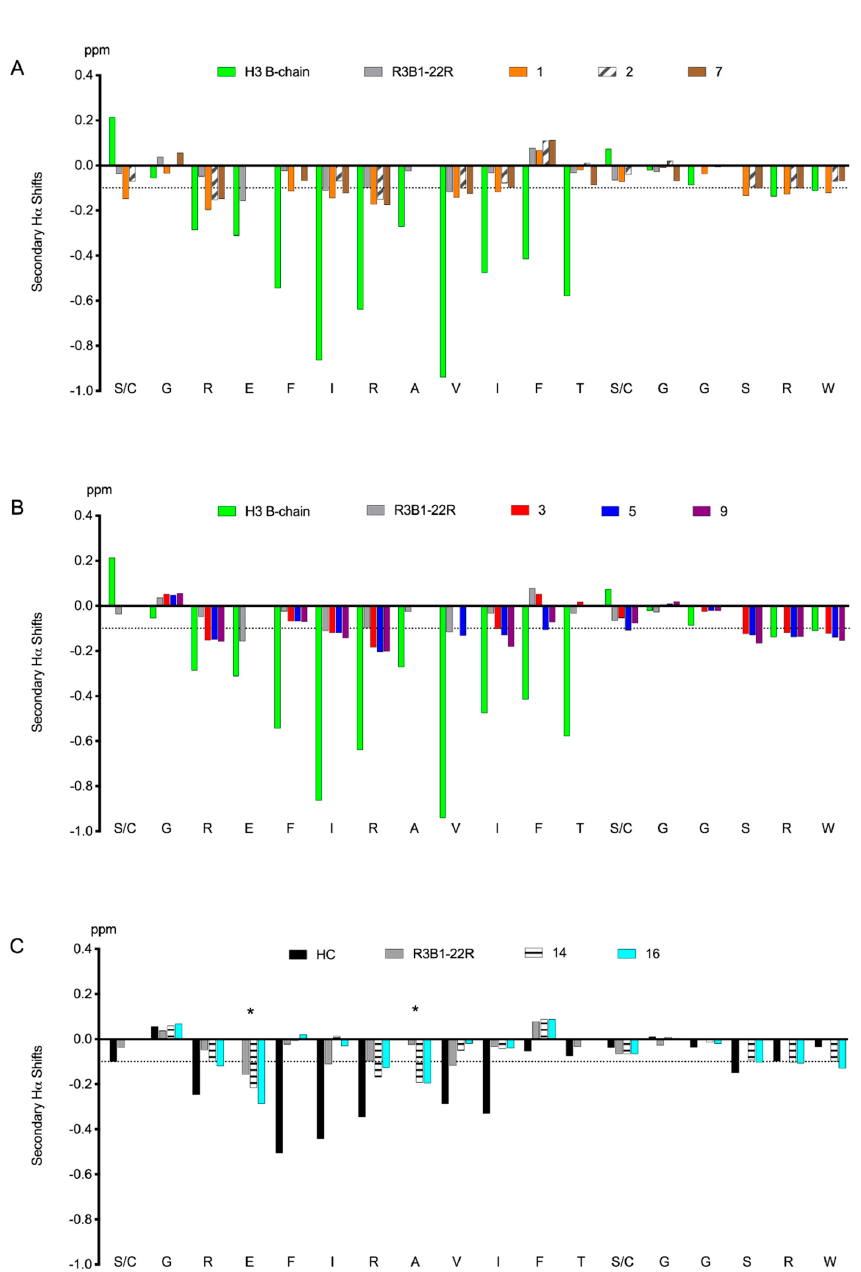
Figure 2. Comparison of secondary H α chemical shift of Aib containing and stapled relaxin-3 analogues. Secondary H α chemical shifts are presented as the recorded chemical shift subtracted by the random coil chemical shift for each amino acid. An extended region of negative values indicates an α -helical structure. Analogues were compared to H3 relaxin B-chain of the native peptide or Ac-R3B10-27 [13 / 17 HC] (HC) and R3B1-22R. ( A ) Comparison between 1 (Ac-R3 B10-27 13, 17 Aib), 2 (Ac-R3 B10-27 13, 14, 17 Aib) and 7 (R3 B10-27 13, 17, 22 Aib), whereas ( B ) shows comparison of 3 (R3 B10-27 13, 17, 18 Aib), 5 (R3B 10-27 13, 17, 21 Aib) and 9 (R3 B10-27 13, 17, 18, 21 Aib). Cysteine-based stapled analogues 14 (R3 B10-27 13, 17 DCA) and 16 (R3 B10-27 13, 17 DBX) are compared in ( C ). * thiol stapling positions. Random coil shifts for Aib and Pa are not available. Oxidised Cys random coil value was for calculation of secondary H α chemical shift at stapled sites of analogues 14 and 16 .